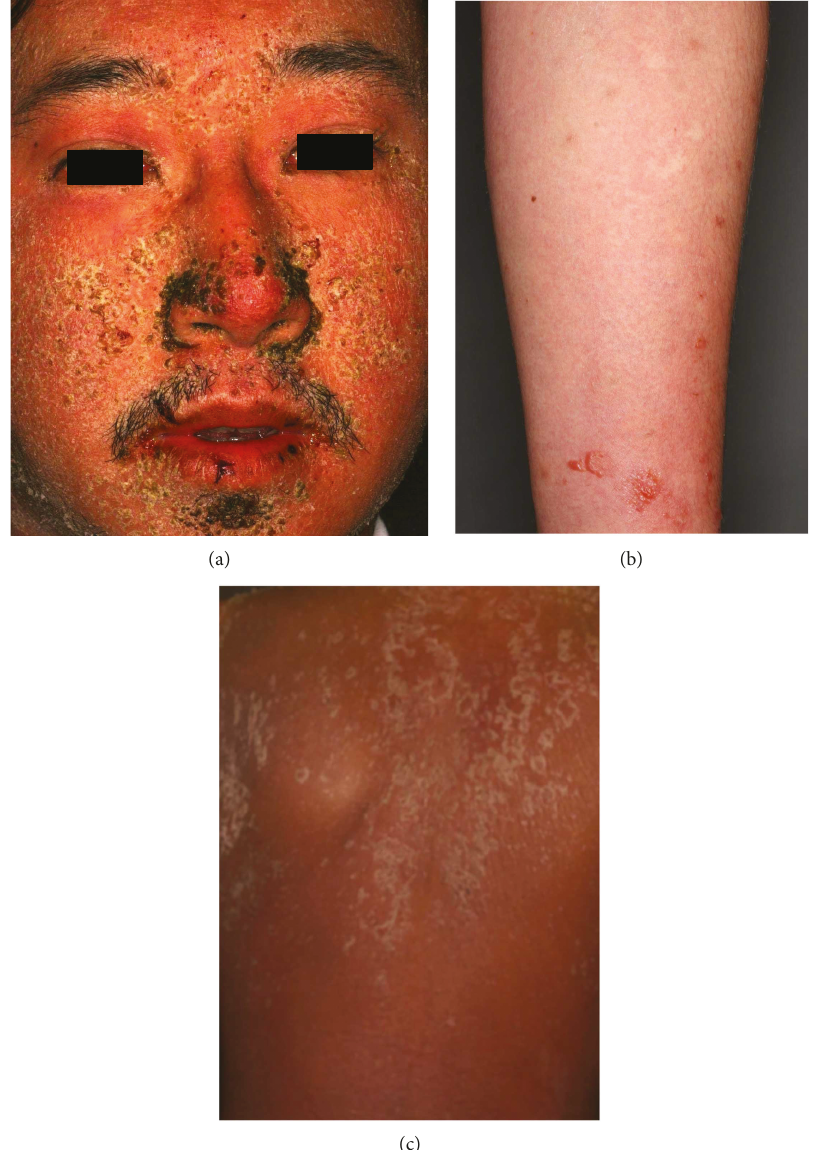
Figure 1: Clinical fi ndings in patients with drug-induced hypersensitivity syndrome (DIHS). (a) Edema and erythema with scaling were observed on the face. Crusts were seen on the lateral surfaces of the nose and around the lips. (b) A di ff use erythematous rash and blisters were seen on the forearm. (c) Di ff use erythema with scaling on the trunk was consistent with